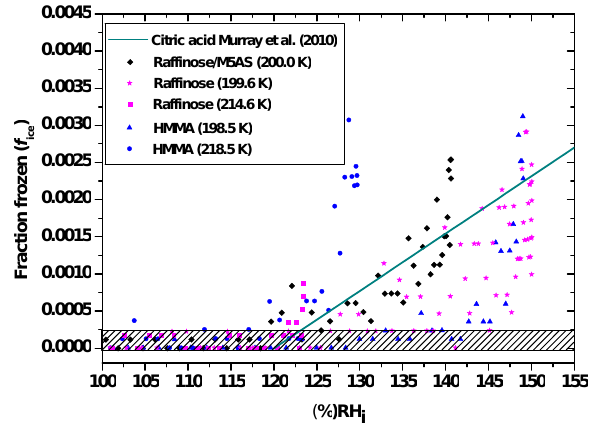
Fig. 8. The fraction of aerosol that froze heterogeneously at tem- peratures above 198K during the expansion experiments shown in Fig. 7. At temperatures below 198K, the ice crystals were too small to allow N ice to be inferred accurately from the WELAS data us- ing a size threshold, preventing the calculation of f ice for those experiments. See figure legend for details. Bracketed numbers in legend indicate the temperature at which the onset of ice nucleation occurred in each case. The solid cyan line is the linear fit ( f ice = 7 . 7211×10 − 5 (% RH i ) – 9.2688×10 − 3 for RH i = 121–170% and f ice = 0 when RH i < 121%) used in Murray et al. (2010b) to pa- rameterise heterogeneous ice nucleation by glassy citric acid so- lution aerosol, which was based on experiment 3 from that study, in which the ice onset occurred at 200.5K. Due to scatter in the ice particle concentration data, a certain amount of noise is present. The shaded region represents a region of uncertainty in which the signal to noise ratio is too low for an accurate estimation of the fraction